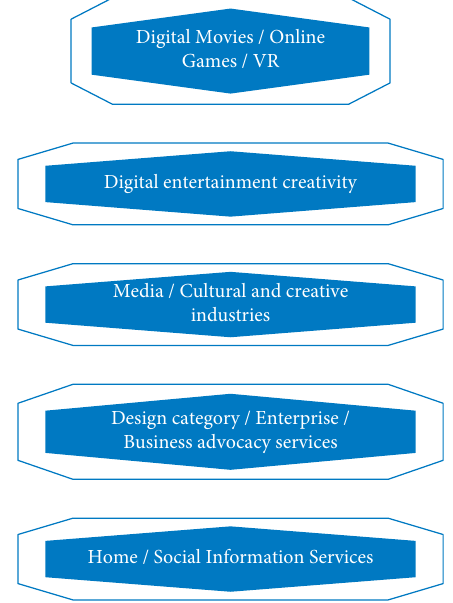
Figure 5: The “pyramid” of the market for digital media